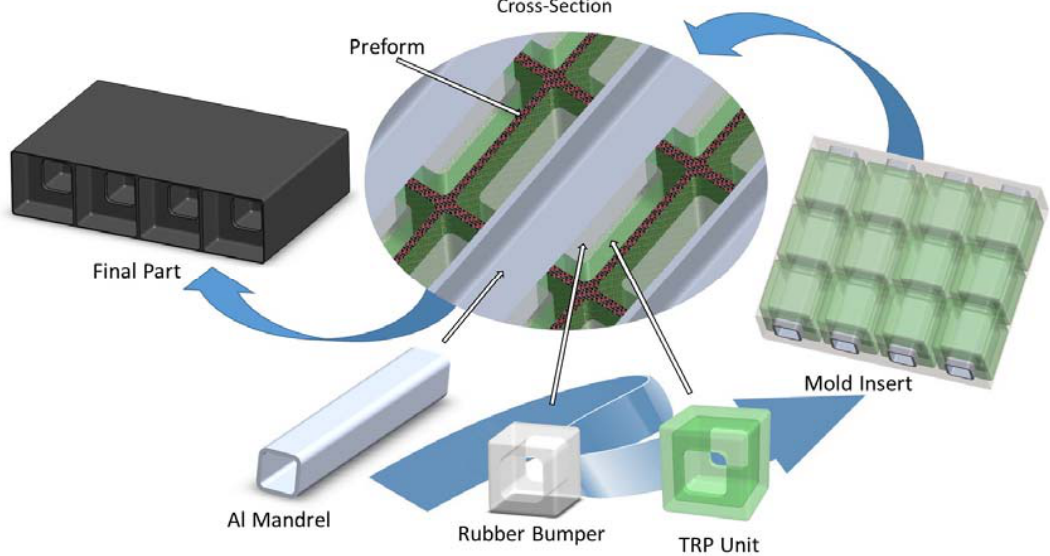
Figure 1. Advanced trapped rubber molding process.